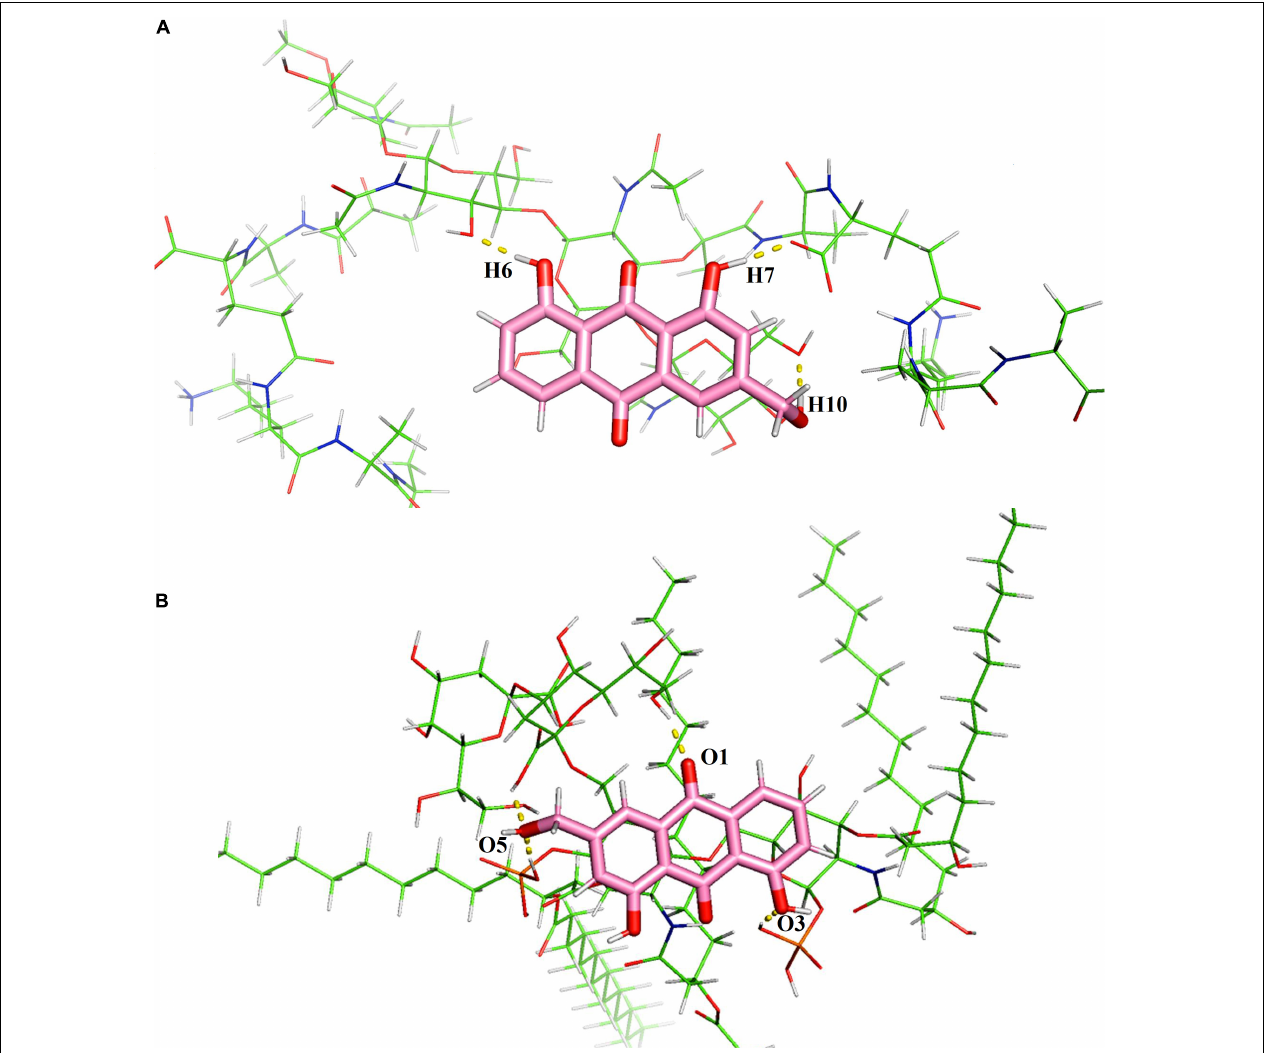
FIGURE 12 | Predicted 3D binding modes of aloe-emodin to the cell membrane. (A) The binding of aloe-emodin to peptidoglycan is driven by four hydrogen bonds with H6, H10, O1, and O2. The binding energy is 1425.7789 kJ/mol. (B) The binding of aloe-emodin to LPS is driven by three hydrogen bonds H6, H7, and H10. The binding energy is -1945.2531